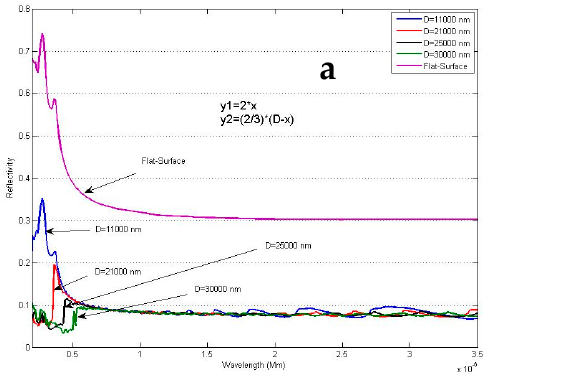
Figure 5. ( a ) Spectral reflection using simulation of the texturing with different coefficients of y 1 and y 2 equations and periodicities of 11, 21, 25 having 30 μ m. The height of the structure for the period of 30 μ m is set to be 15 μ m, ( b ) comparison of two microstructures with periods of 25 and 30 μ m. Note that the larger the number of ripples, the lower the skin's spectral reflectance.